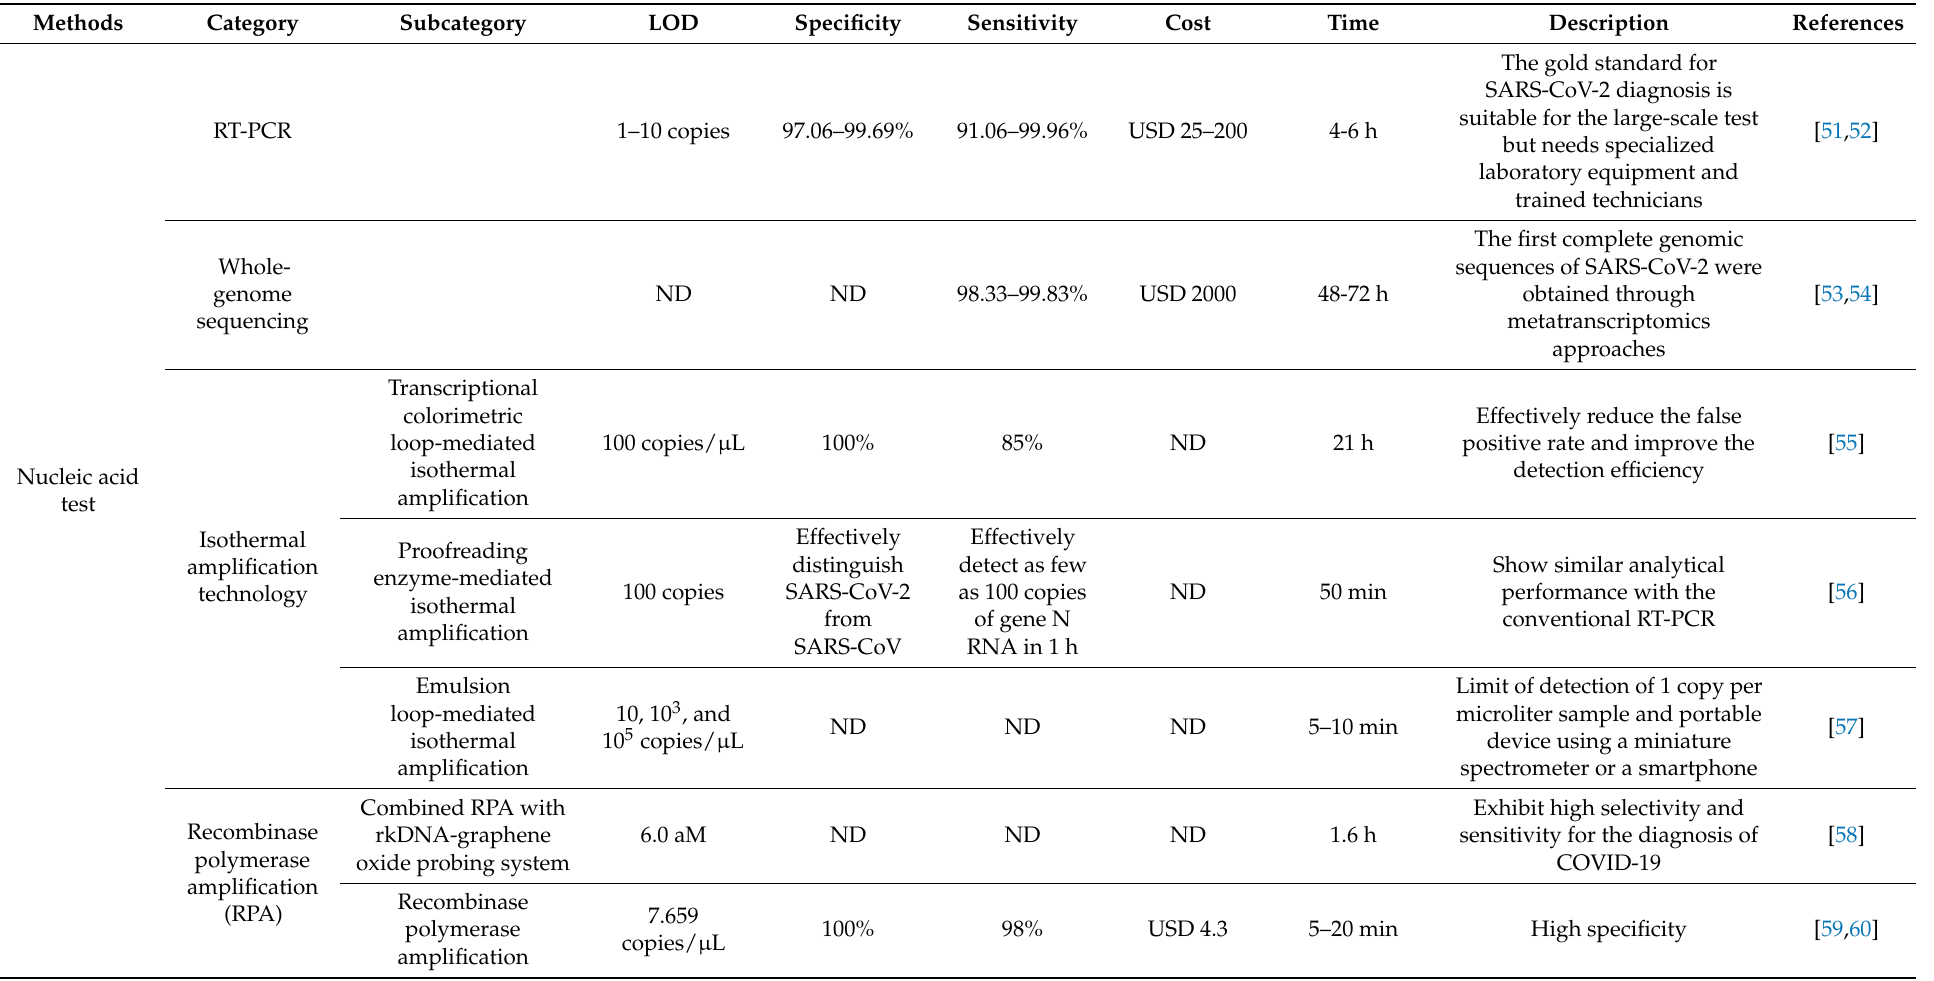
Table 1. The advance of SARS-CoV-2 test